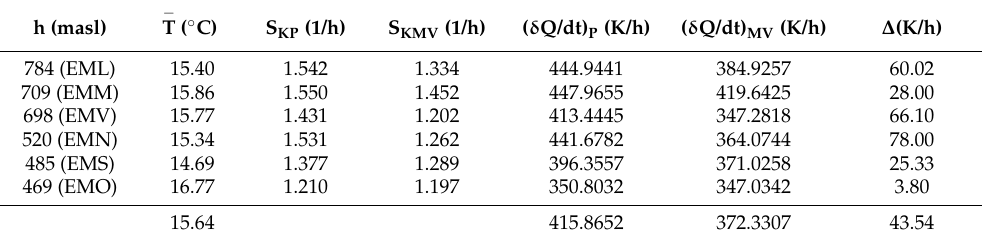
Table 6. Contains the average temperature for the measurement period 2010–2013 and the difference between temporal heat variation between pollutants and meteorological variables using Equation (30). The last row are average values.